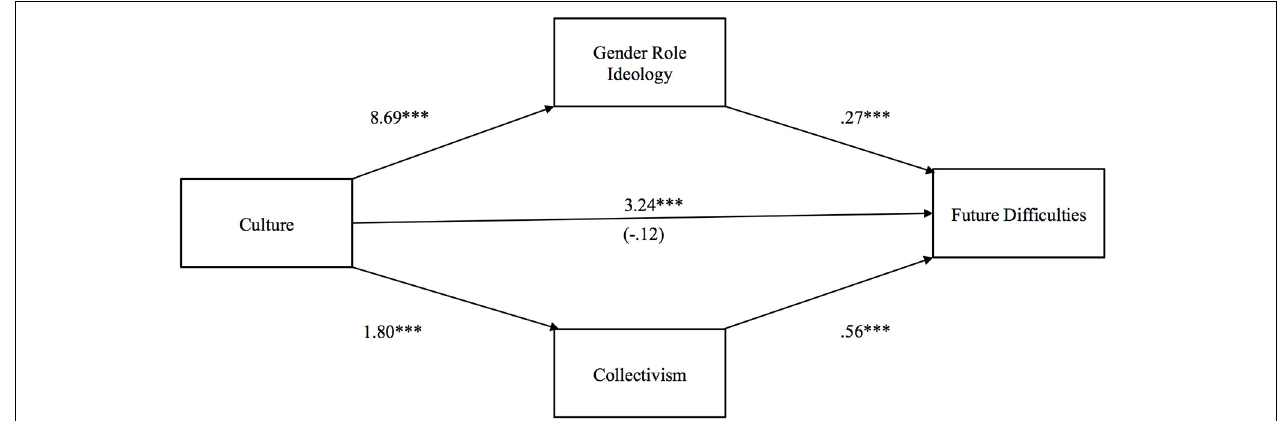
FIGURE 3 | Indirect effect of culture on future difficulties on marital life through gender role ideology and collectivism. The value in parentheses represents the direct effect, and the value directly above is the total effect. ∗ p < 0 . 05, ∗∗ p < 0 . 01, ∗∗∗ p < 0 .